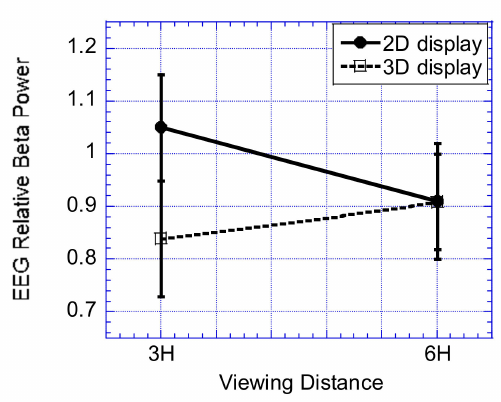
Figure 4. Effect of viewing distance by display type interaction on relative β power (%).